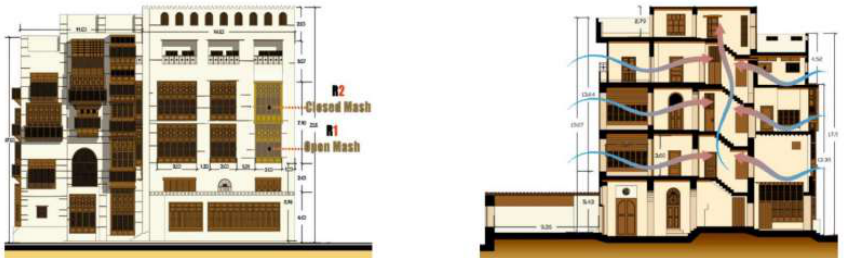
Figure 10. Western façade ( left ) and a cross section with a general perception of the airflow ( right ).